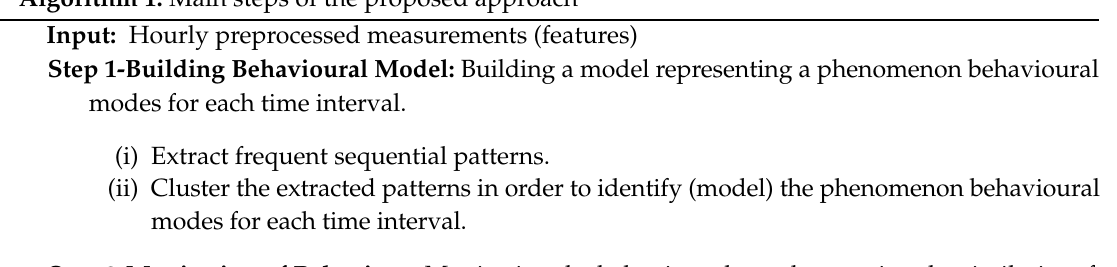
Algorithm 1: Main steps of the proposed approach Input: Hourly preprocessed measurements